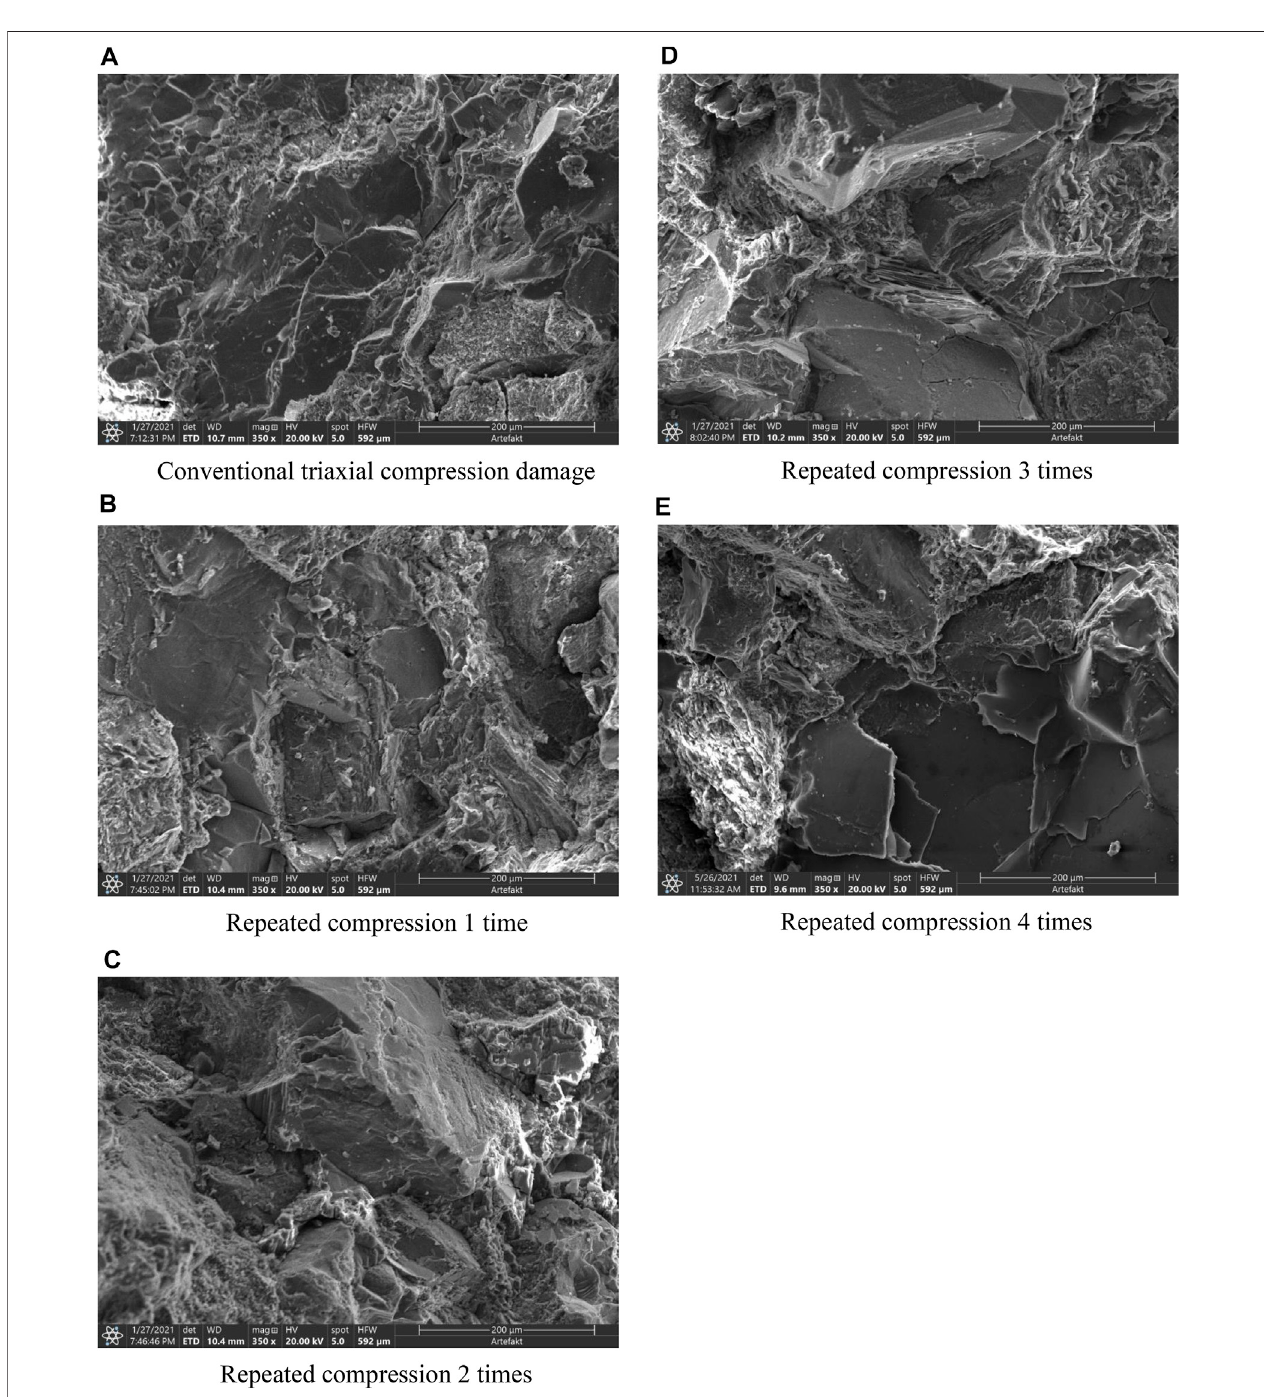
FIGURE 4 | SEM microscopic morphology of rock fracture. (A) Conventional triaxial compression damage. (B) Repeated compression 1 time. (C) Repeated compression 2 times. (D) Repeated compression 3 times. (E) Repeated compression 4 times.